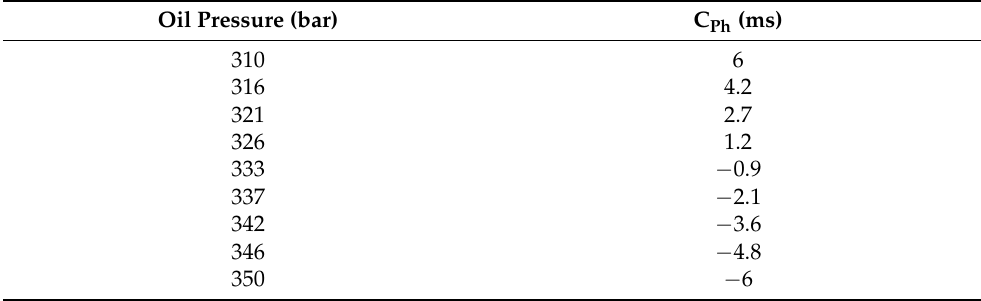
Figure 21. Dependency of t U on the DC voltage supply on the connection of a circuit breaker. 4. The oil pressure dependency of time coefficient C Ph = f(P) on the connection of a circuit breaker is represented in Table 9. Taking into consideration the measured values, the equation which describes the dependency is presented in Equation (22). Table 9. Measured values of the dependency of time coefficient on oil pressure.